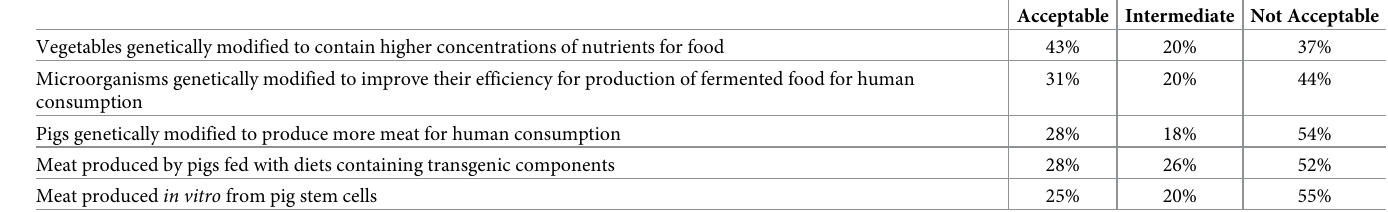
Acceptable Intermediate Not Acceptable 31% 44%